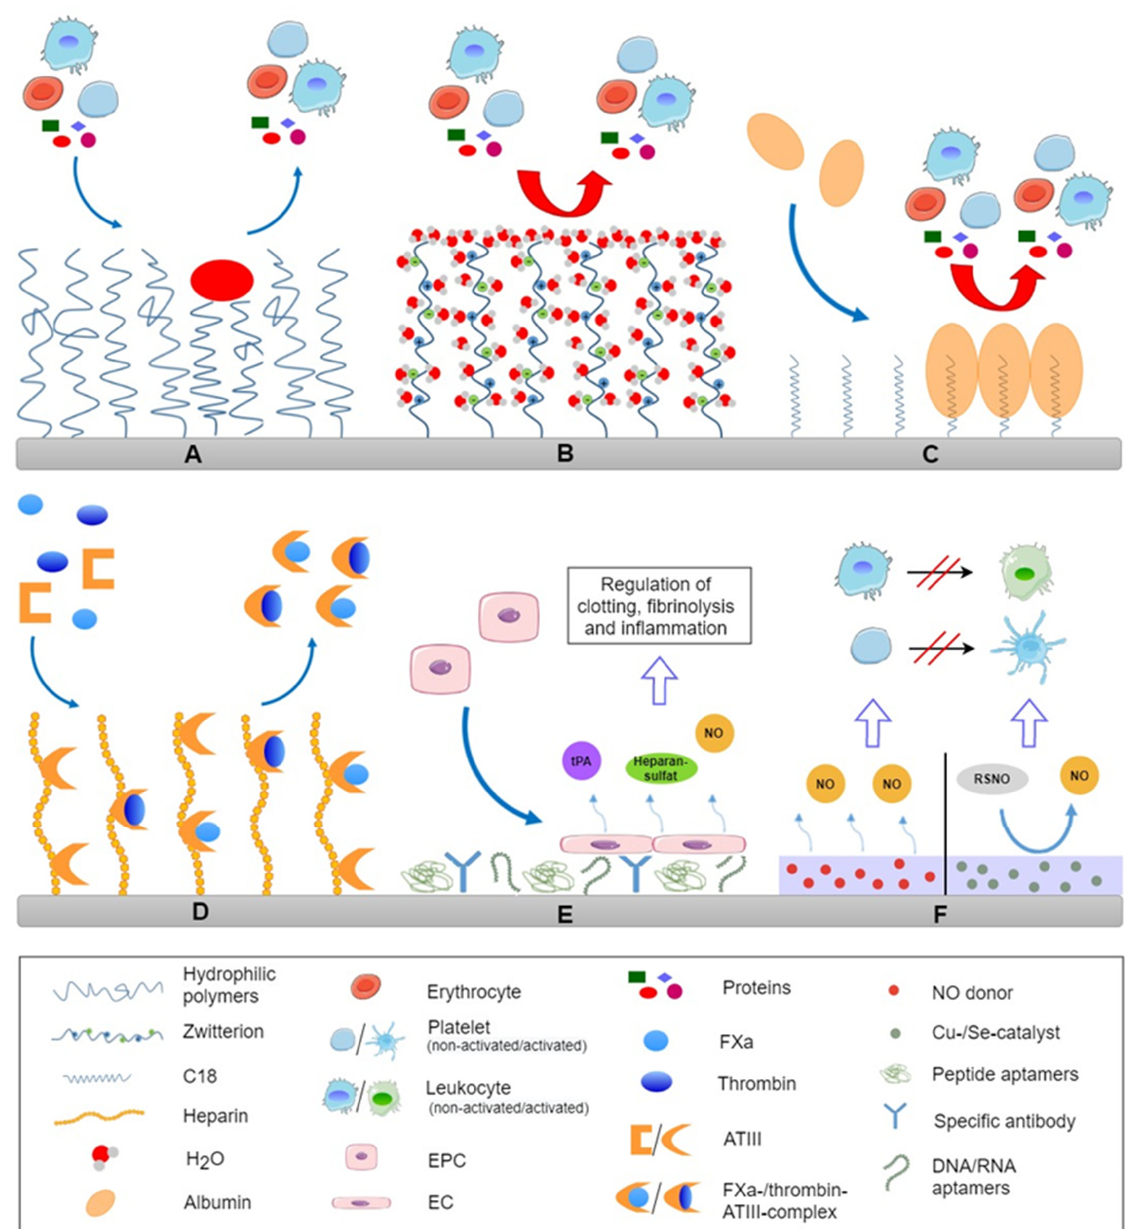
Figure 2. Survey on different design of blood compatible surfaces by steric repulsion through immobilization of mobile hydrophilic macromolecules ( A ), zwitterionic molecules that lead to tight binding of water molecules causing strong repulsive hydration forces ( B ), preferential binding of a passivating protein layer from plasma, like immobilization of C18 fatty acids for preferential adsorption of albumin ( C ), end-on immobilization of heparin for binding anti-thrombin III for inactivation of thrombin (FIIa), factor Xa and other coagulation factors ( D ), immobilization of antibodies or aptamers for preferential adhesion of endothelial progenitor cells from circulation for formation of an endothelial lining ( E ) and NO releasing/generating surfaces for control of leukocyte and platelet activation ( F ).